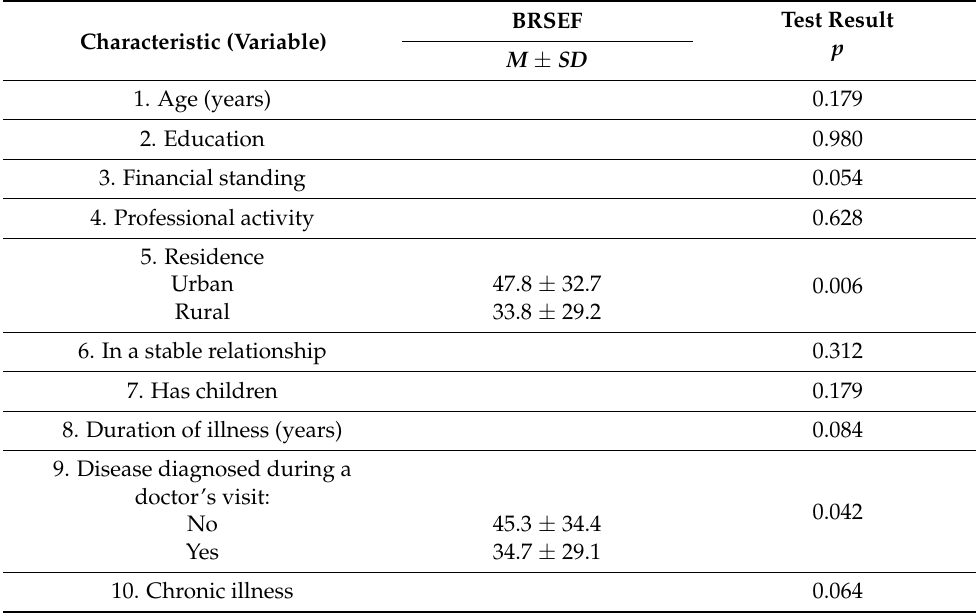
Table 2. Sexual functioning (EORTC QLQ-BR23 BRSEF domain) in patients differing in terms of selected socio-demographic and clinical characteristics, with test